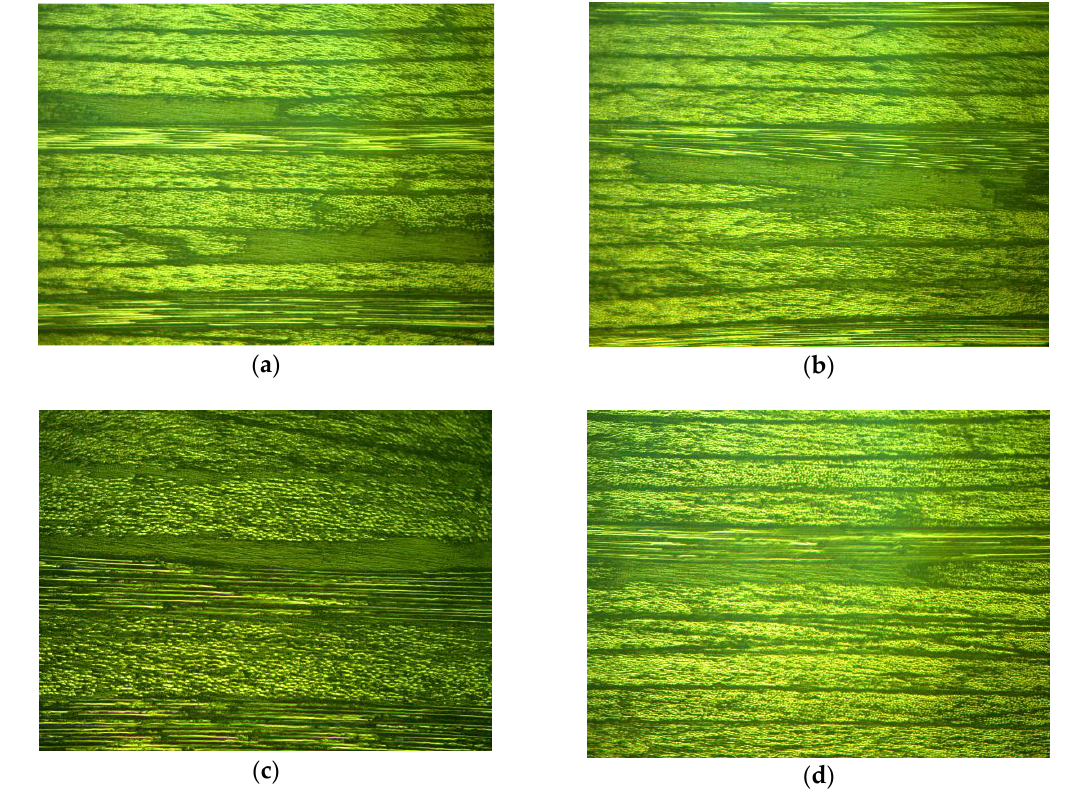
Figure 11. Rich-resin areas in the specimen. ( a ) Layer: 10 and 14; ( b ) layer: 25; ( c ) layer: 31; and ( d ) layer: 42.